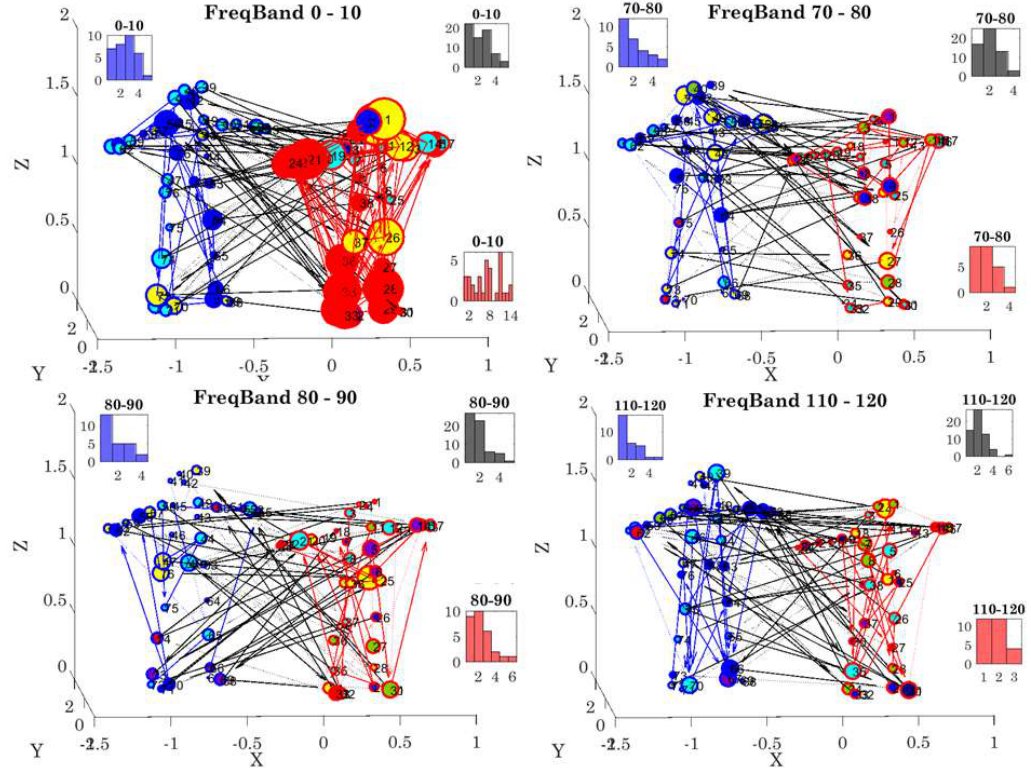
Figure 10. Sample degree distributions for different frequency bands in one snippet of data reflecting the state of the network differently for lower vs. higher frequencies. Each inset frequency histogram reflects the number of K edges on the x -axis and the number of nodes with k edges along the y -axis. The color of the frequency histogram corresponds to the color of the links. Red reflects the female inner links; blue the male inner links; and black the coupled network inter links. Arrows reflect the directionality and thickness the phase shift (thicker values are higher shifts). Note the differences in degree connectivity between lower and higher frequency bands for each of the subnetworks of interest.